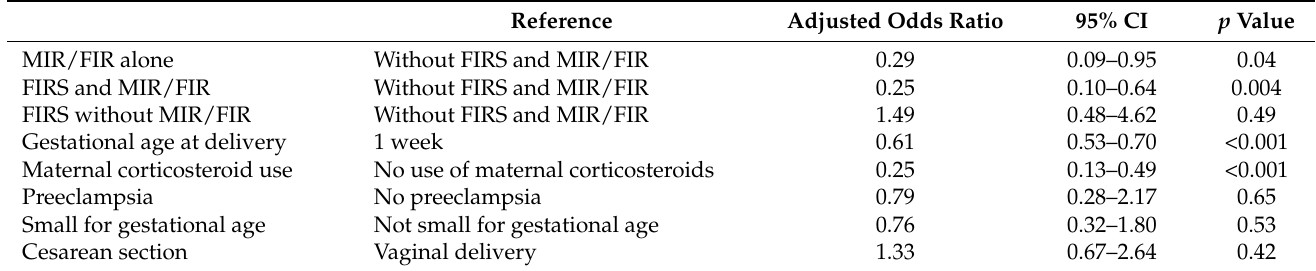
Table 4. Multivariate logistic regression analysis of the presence of respiratory distress syndrome.